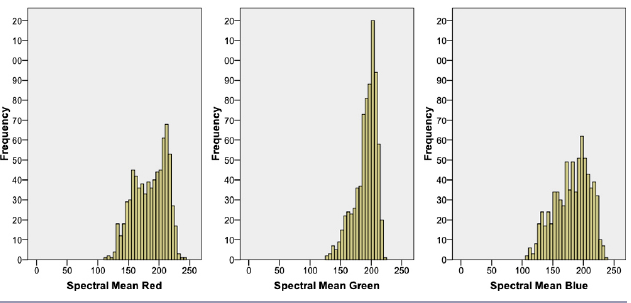
Fig. 6 . Frequency histograms showing the distribution of values for the “spectral mean” attribute in each of the three image bands among 744 manually identified Lesser Snow Geese ( Chen caerulescens caerulescens ) in 5-cm resolution aerial imagery. Greater spectral consistency of geese in the green band is evident compared to the red and blue bands.